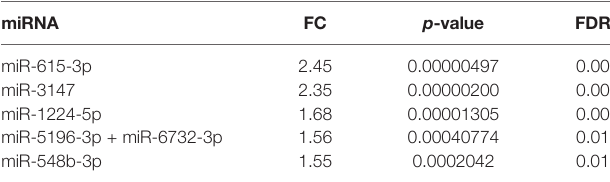
TABLE 2 | MiRNAs upregulated in T2DM IHD compared with T2DM patients.